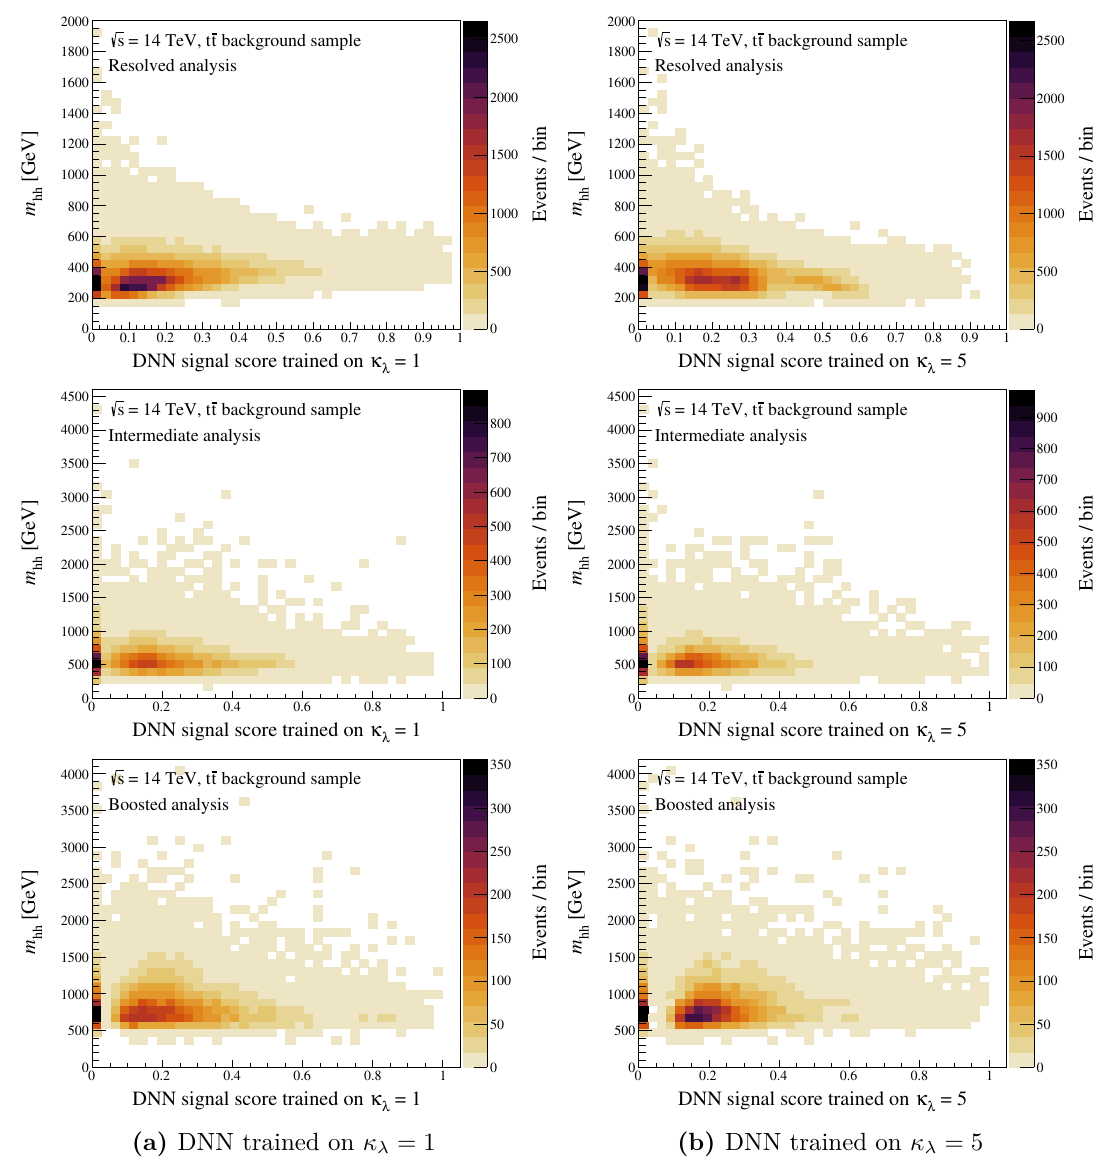
Figure 25. The di-Higgs invariant mass m hh vs neural network scores trained on (a) κ λ = 1 and (b) κ λ = 5 signal sample for the (upper) resolved, (middle) intermediate, and (lower) boosted analyses. The test samples used to make these distributions are an independent set of t ¯ t